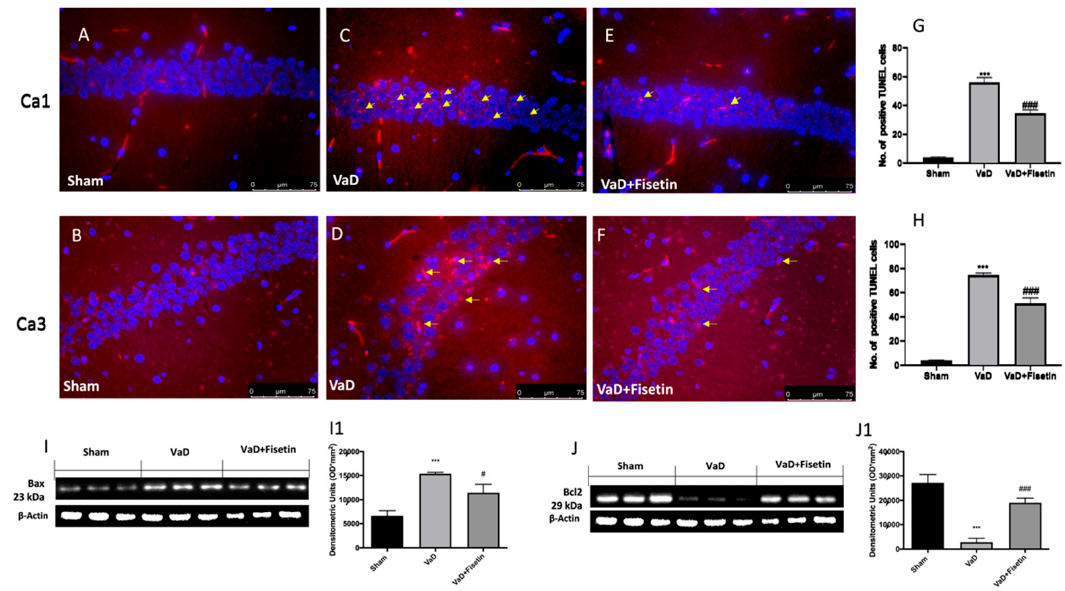
Figure 6. Fisetin administration on VaD induced apoptosis. TUNEL staining to see positive apoptotic cells (yellow arrows) was performed. Sham ( A , B ), VaD + vehicle ( C , D ), VaD + Fisetin ( E , F ). The number of apoptotic cells in CA1 and CA3 subfields of hippocampus ( G , H ). Figures are from at least three divided experiments. Western blots for Bax and Bcl-2 ( I , I1 , J , J1 ). Exposed is a blot of lysates (6 animals/group) with a densitometric analysis for all animals. The results = means ± SEM of 6 animals for each group. *** p < 0.001 vs. sham; ### p < 0.001 vs. VaD; # p < 0.05 vs. VaD. Scale bar: 75 μ m. Magnification (40X).